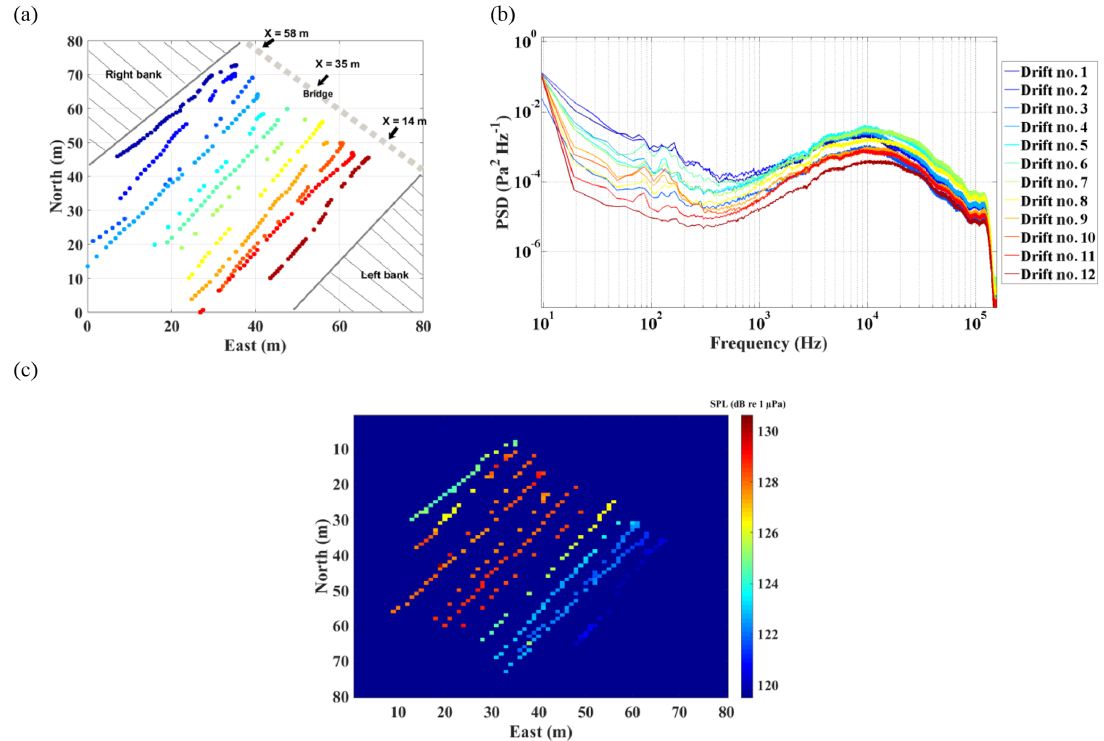
Figure 6. (a) Positions of the floating board during drift experiments, with essential positions marked on the bridge, X = {14, 35, 58}m across the river; (b) the PSD estimated from the 12 drifts, in units of Pa 2 Hz − 1 ; to be noted is the change in peak frequencies: the leftmost position (Drift no. 12) has the highest frequency, meaning that the finer size fractions are transported, and the particles are getting coarser up to the right bank; (c) the measured SPL map from the 12 drifts, in units of dB re 1µPa; the maximum values are found in the middle of the Isère River’s cross section.